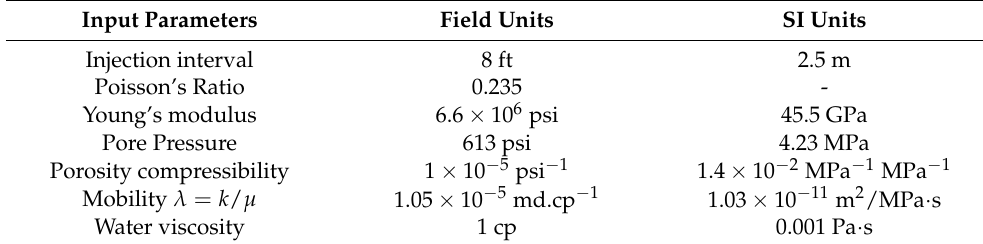
Table 5. Mechanical and reservoir parameters of 4100 ft